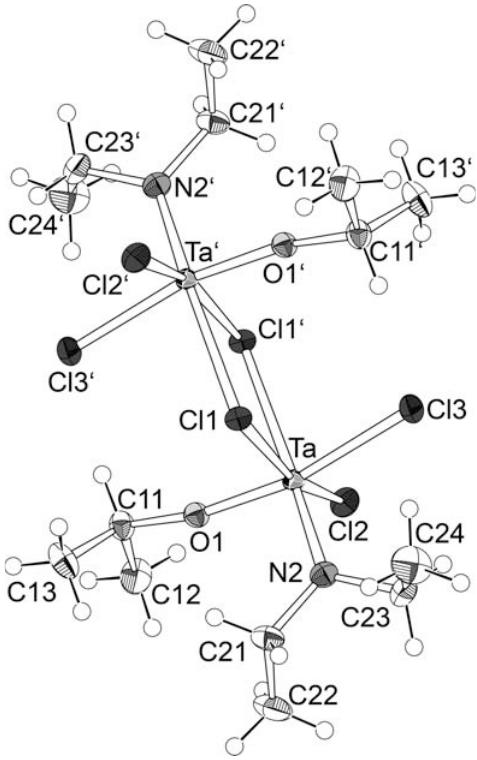
Table 2. Atomic coordinates and displacement parameters (in Å 2 )